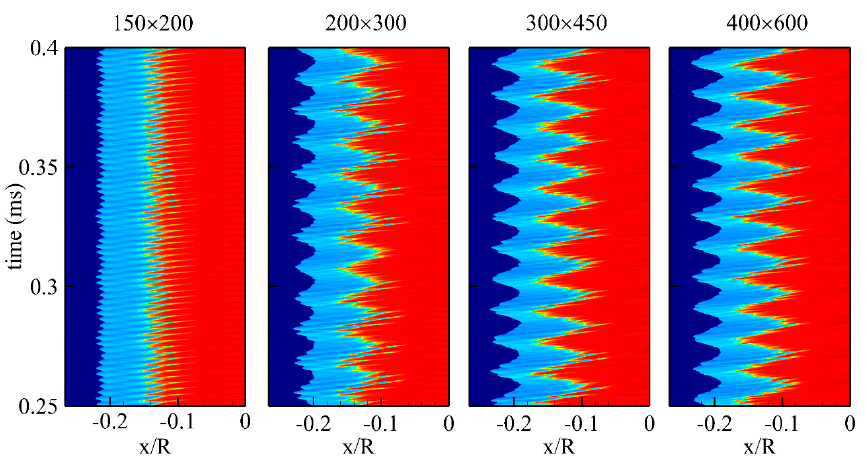
Figure 15. Streamline extraction of the temperature contour for the Dryer mechanism at various grid levels. Color scale is the same as Figure 9.